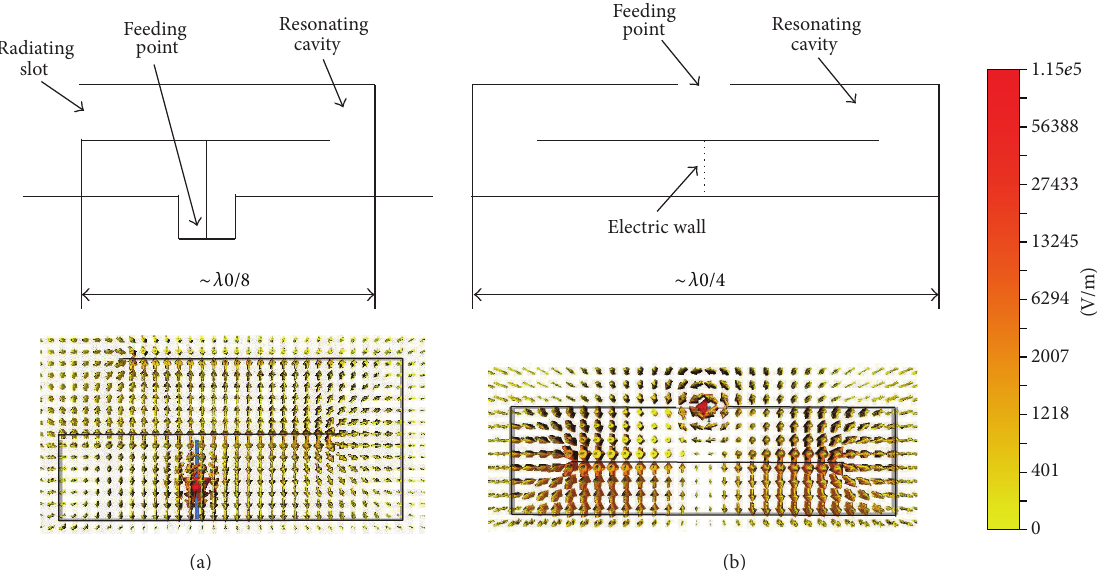
Figure 1: The side cross-section and electric field distribution of the vertically folded quarter wavelength patch antenna (a) and the proposed vertically folded coupled patches antenna (b).